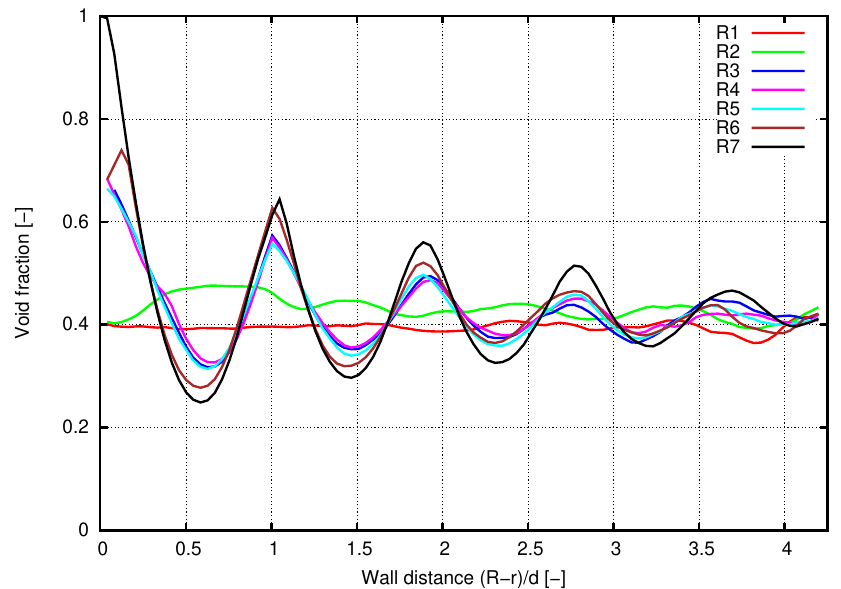
Figure 8. Averaged radial void fraction profiles for different wall structures.